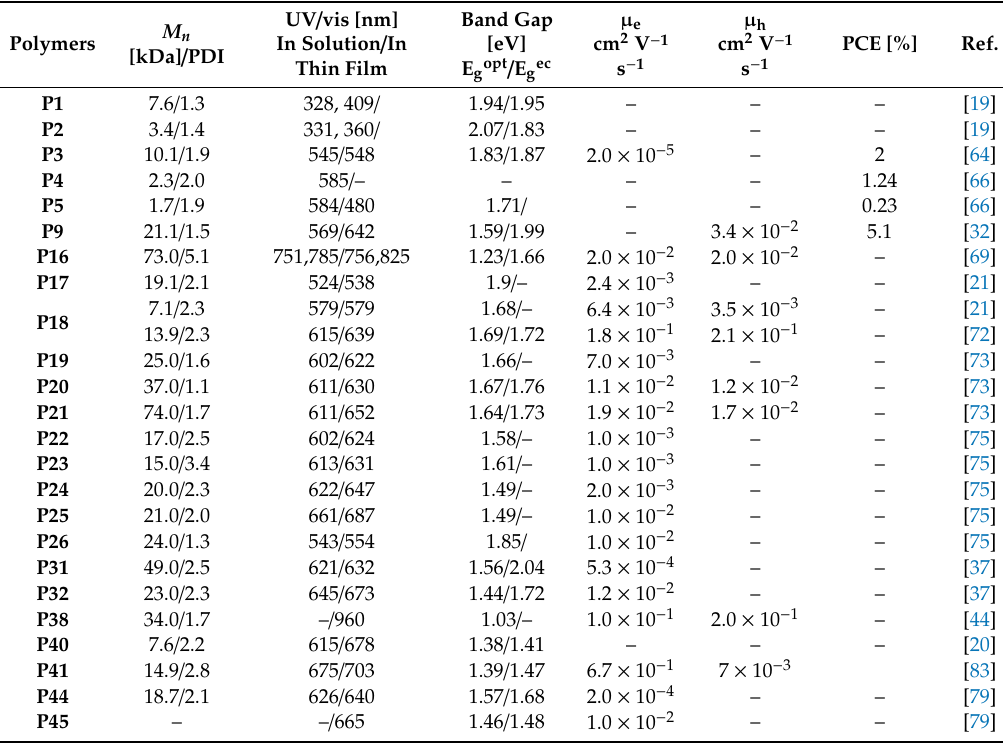
Table 2. List of properties of polymers based on isoDPP, BDP, and